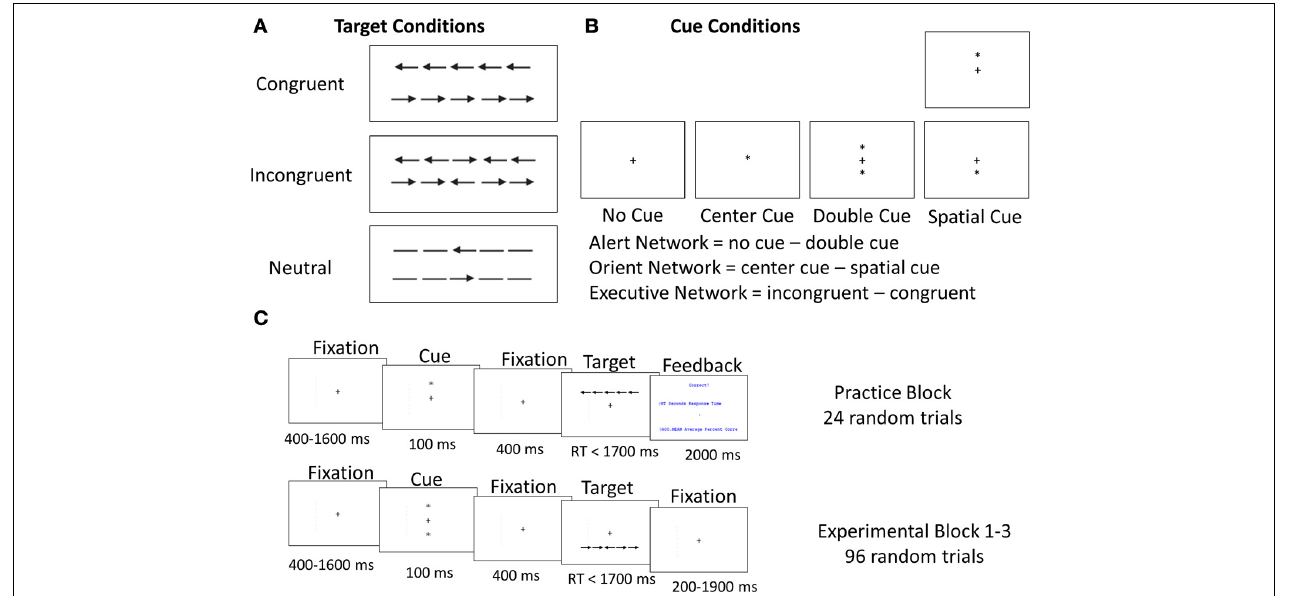
FIGURE 1 | Attention Network Task (ANT). (A) Target conditions, (B) Cue conditions, (C) Experimental